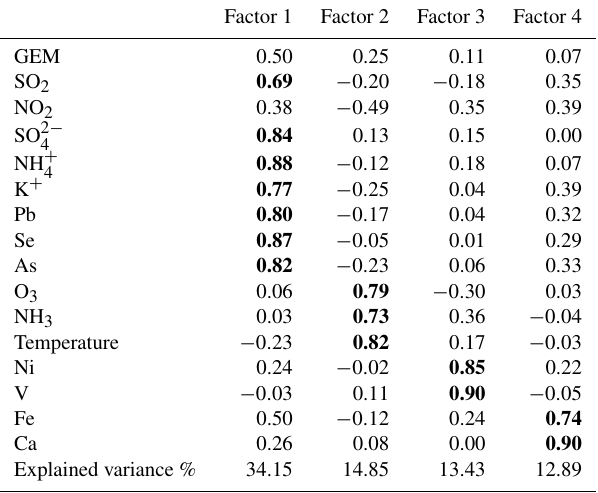
Table 2. PCA (principal component analysis) for GEM at DSL. Note that bold values represent high loading (factor loading >